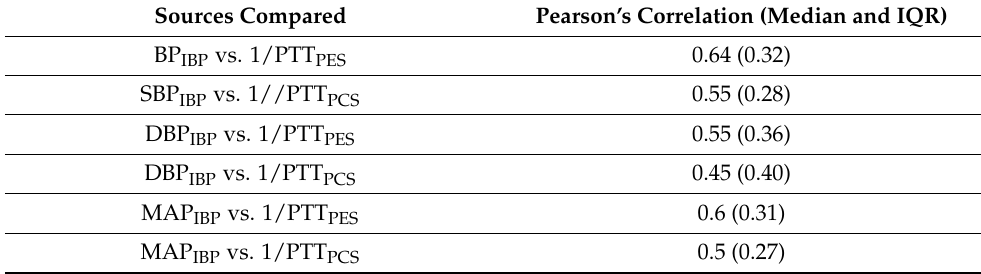
Table 2. Correlation between 1/PTT via PES/PCS and SBP IBP , DBP IBP , and MAP IBP . Pearson correlation coefficient (r) and IQR are